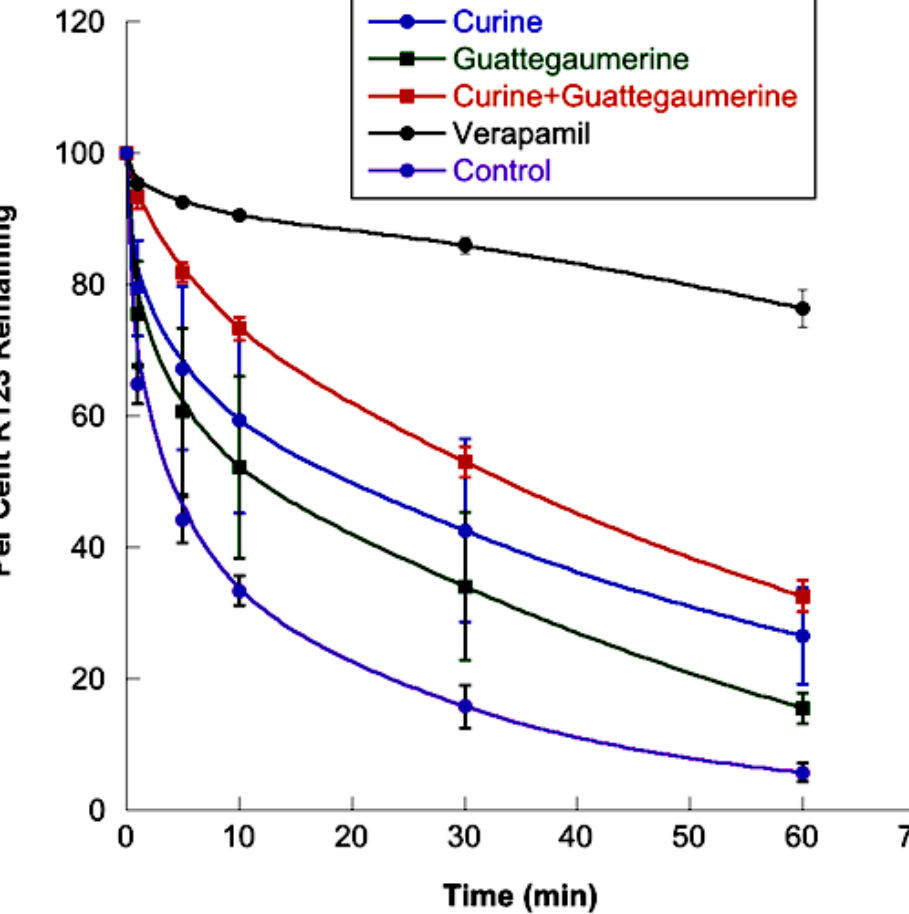
Figure 4. Effects of curine and guattegaumerine on the efflux of rhodamine from HTC-R cells. The cells were grown to confluence in DMEM, and rhodamine accumulated for 90 min at 37 ◦ C. After washing the cells, the efflux of rhodamine was initiated at 37 ◦ C by the addition of PBS (control) or PBS containing curine or guattegaumerine at 100 µ M. For the time indicated in abscissa, the amount of rhodamine output from the cells was measured by fluorescence. The results are expressed as a percentage of rhodamine 123 remaining in the cells. These results are representative of at least two independent experiments and show the mean ± SD of triplicate